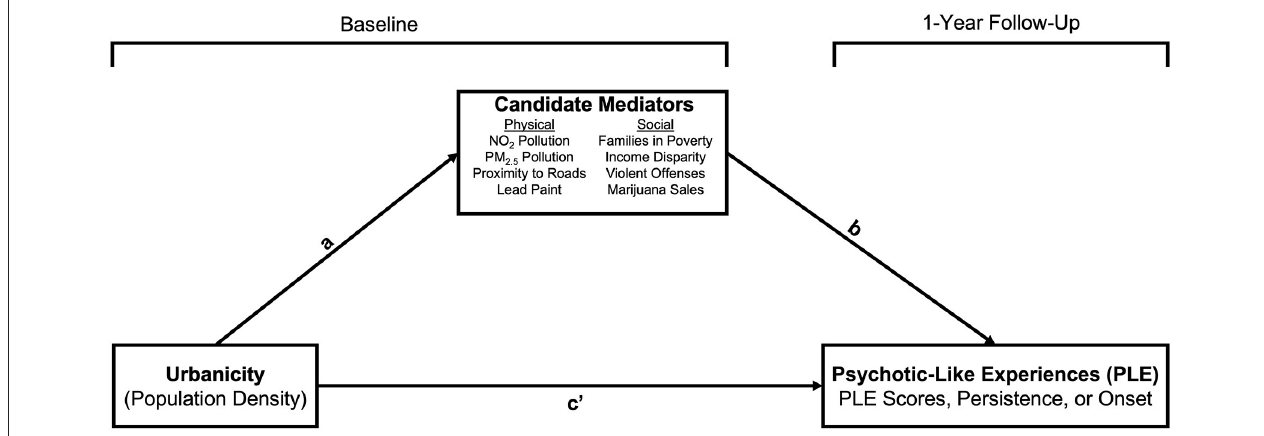
FIGURE 1 | Mediation model. Age (in months) and sex-at-birth (M > F) were included as covariates on paths a and b.